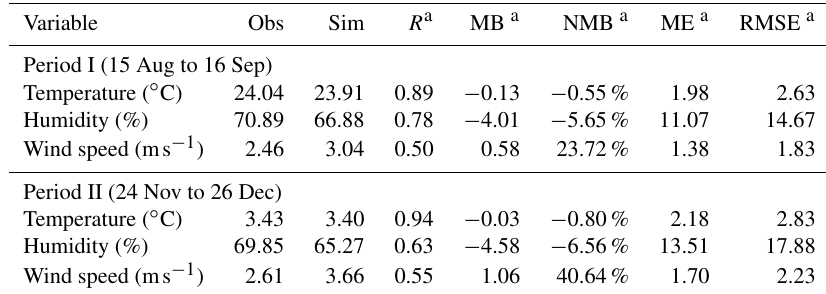
Table 2. Statistical evaluations of the model meteorological performance. Variable Obs Sim